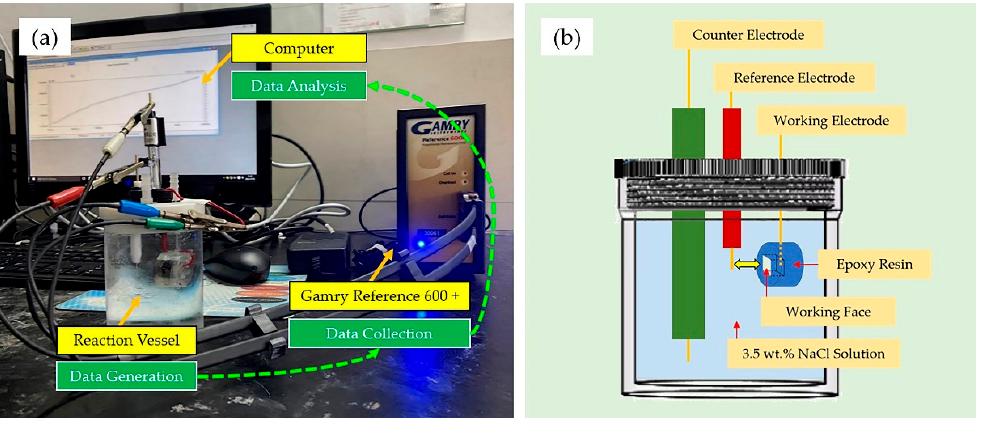
Figure 3. Electrochemical workstation: ( a ) Gamry Reference 600+; ( b ) schematic diagram of the three-electrode system.